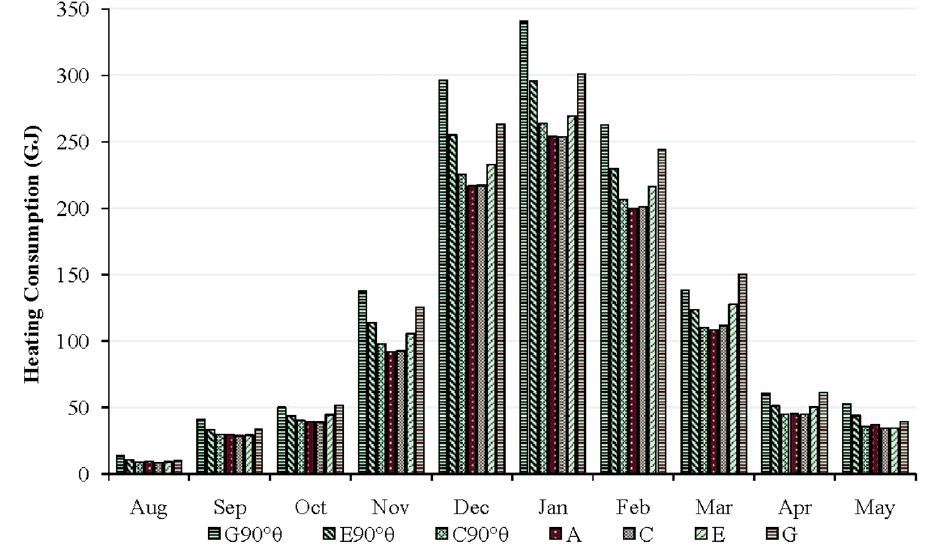
Figure 9. Monthly heating consumption for different aspect ratios in Toronto.